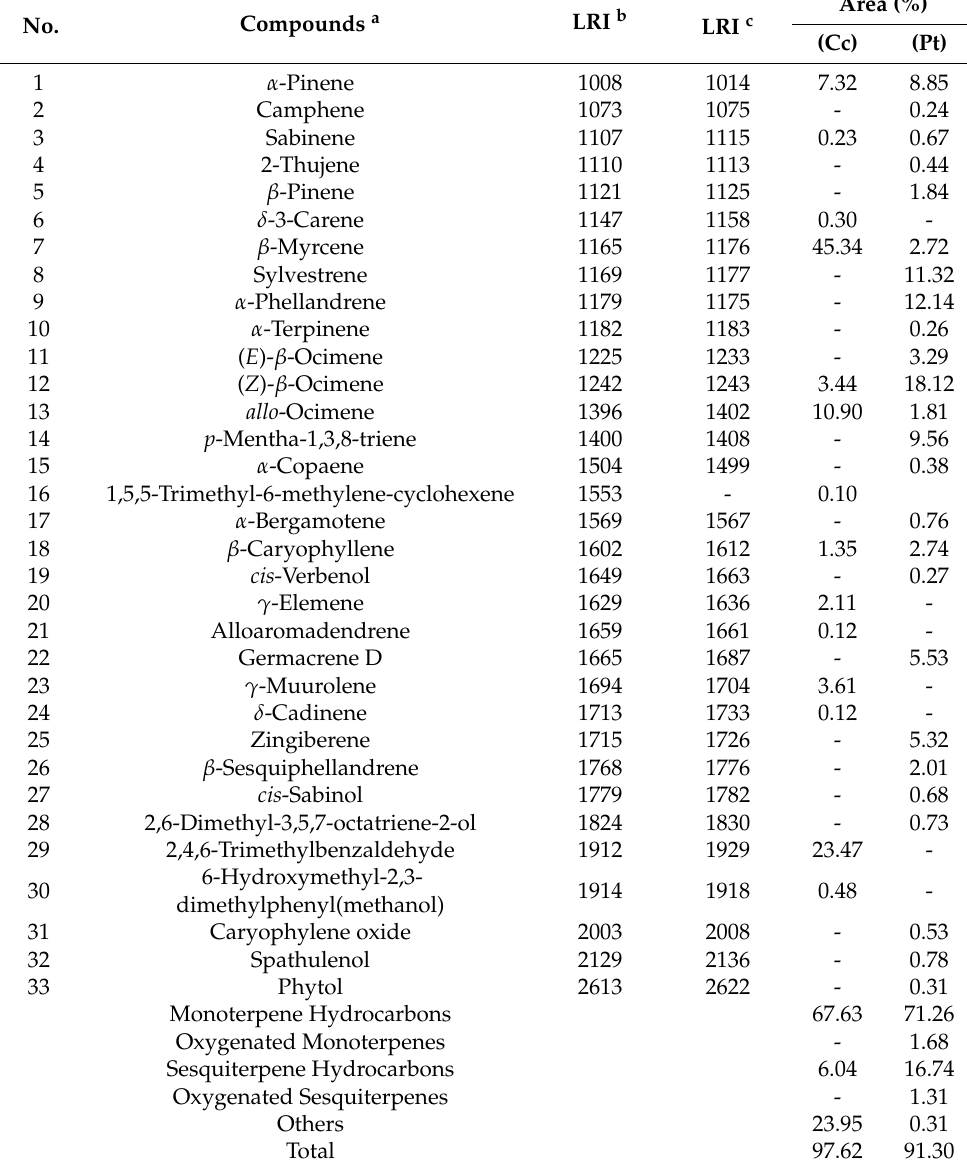
Table 1. Chemical composition (%) of Cachrys cristata (Cc) and Prangos trifida (Pt) essential oils (EOs). No. Compounds